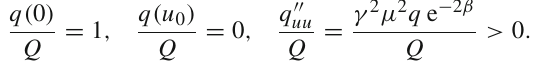
Fig. 4 Dependencebetweentheratio Q /μ andthedimensionlessmass M / R μ , where R μ = κμ 2 / 2, for the solution with the regular elec- tric field. Panels relate to specific values of the coupling parameter α = 1 ,..., 3. The range M / R μ ∈ [ 0 , 1 ) on the horizontal axis corre-